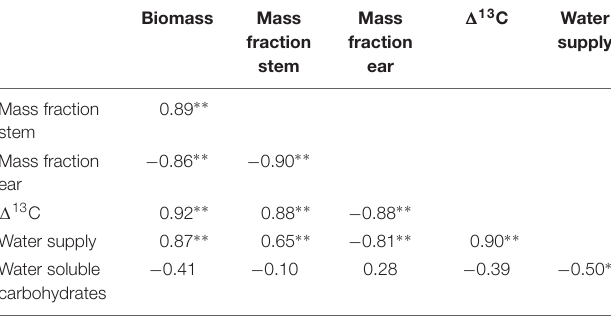
TABLE 2 | Correlation matrix of crop traits at anthesis (biomass, mass stem fraction, mass ear fraction, (cid:49) 13 C, concentration of water soluble carbohydrates) and environmental factor (water supply) that contributed to the scatter of the %Nc-biomass